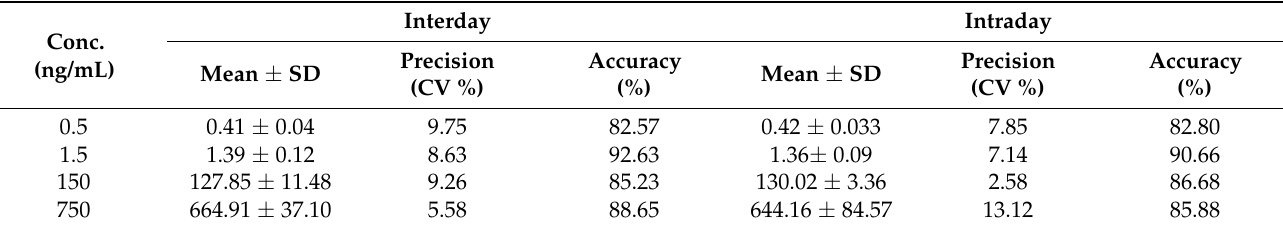
Table 2. Inter- and intraday precision and accuracy of PX in plasma.